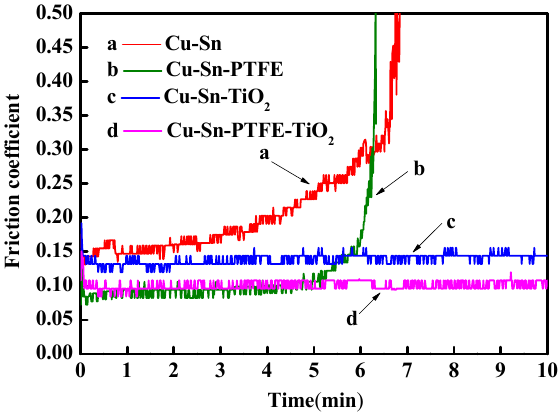
Figure 8. The friction coefficient curve of each Cu–Sn base plating coating.